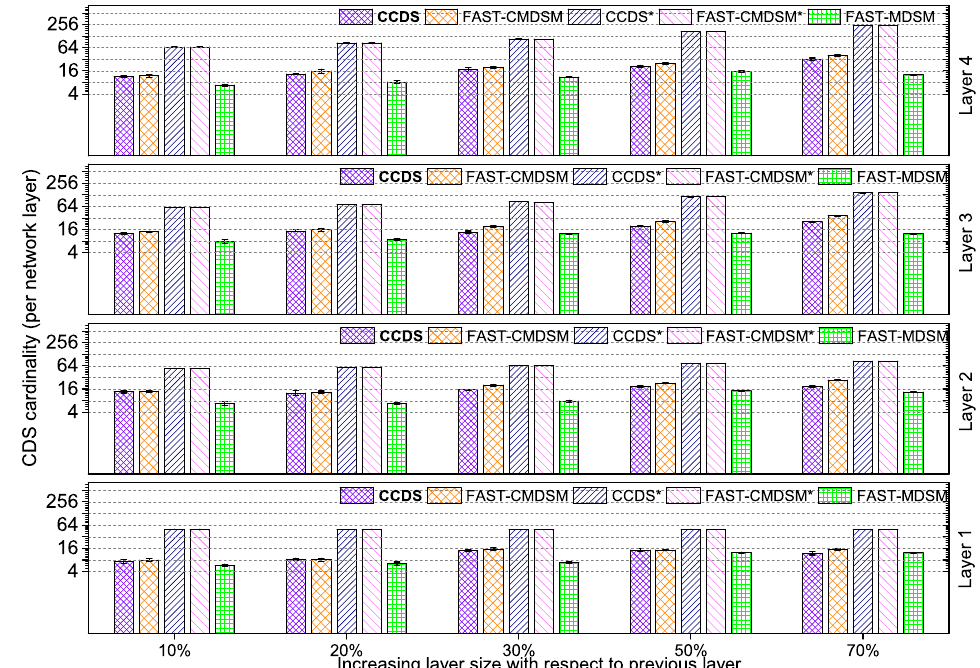
Figure 15. Impact of increasing layer cardinality (Low